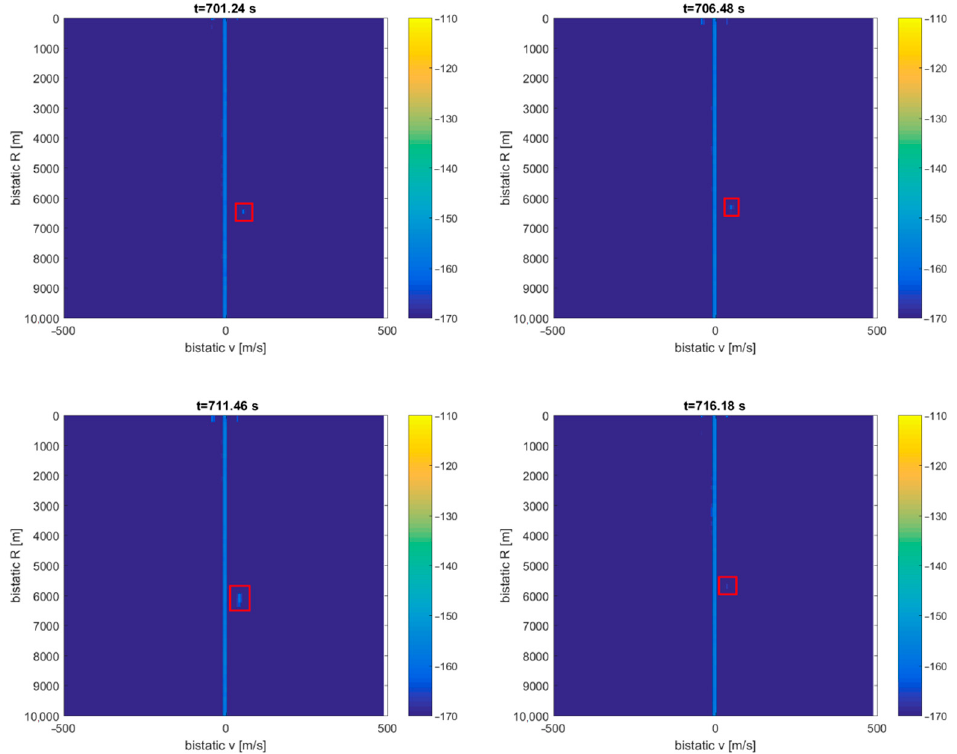
Figure 27. Detection results of the LOT4CG airplane (scene in Figure 26).